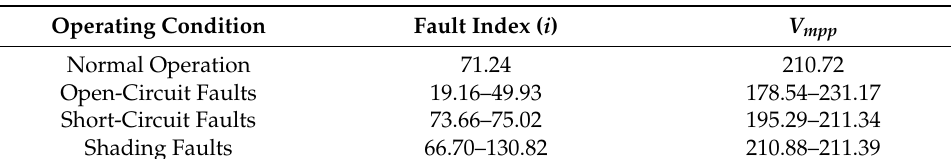
Figure 3. Fuzzy rule view. ( a ) Open ‐ circuit fault. ( b ) Short ‐ circuit fault. ( c ) Shadowing fault.